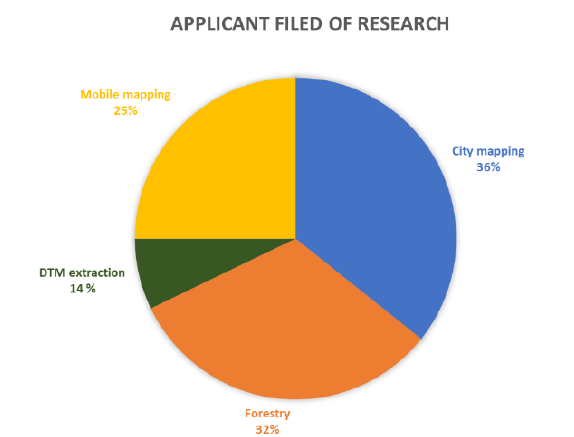
Figure 6 . Research field of the applicants.